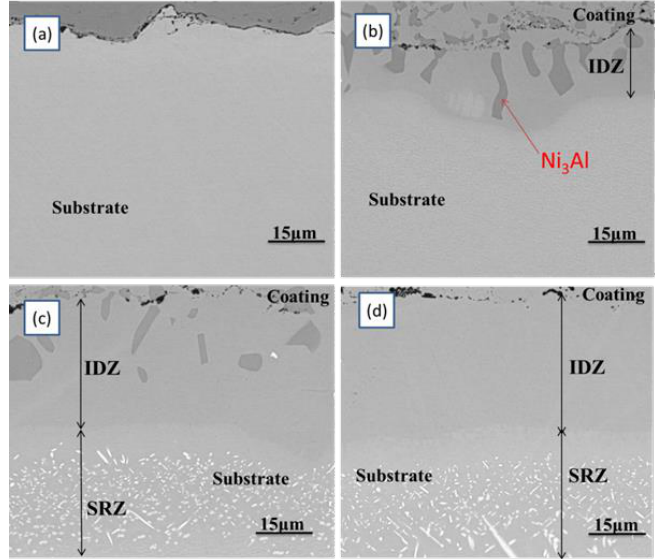
Figure 4. Cross-section of NiCoCrAlY coating/N5 single crystal superalloy after static oxidation at 1100 °C for different time: ( a ) 0 h; ( b ) 50 h; ( c ) 100 h; ( d ) 200 h.